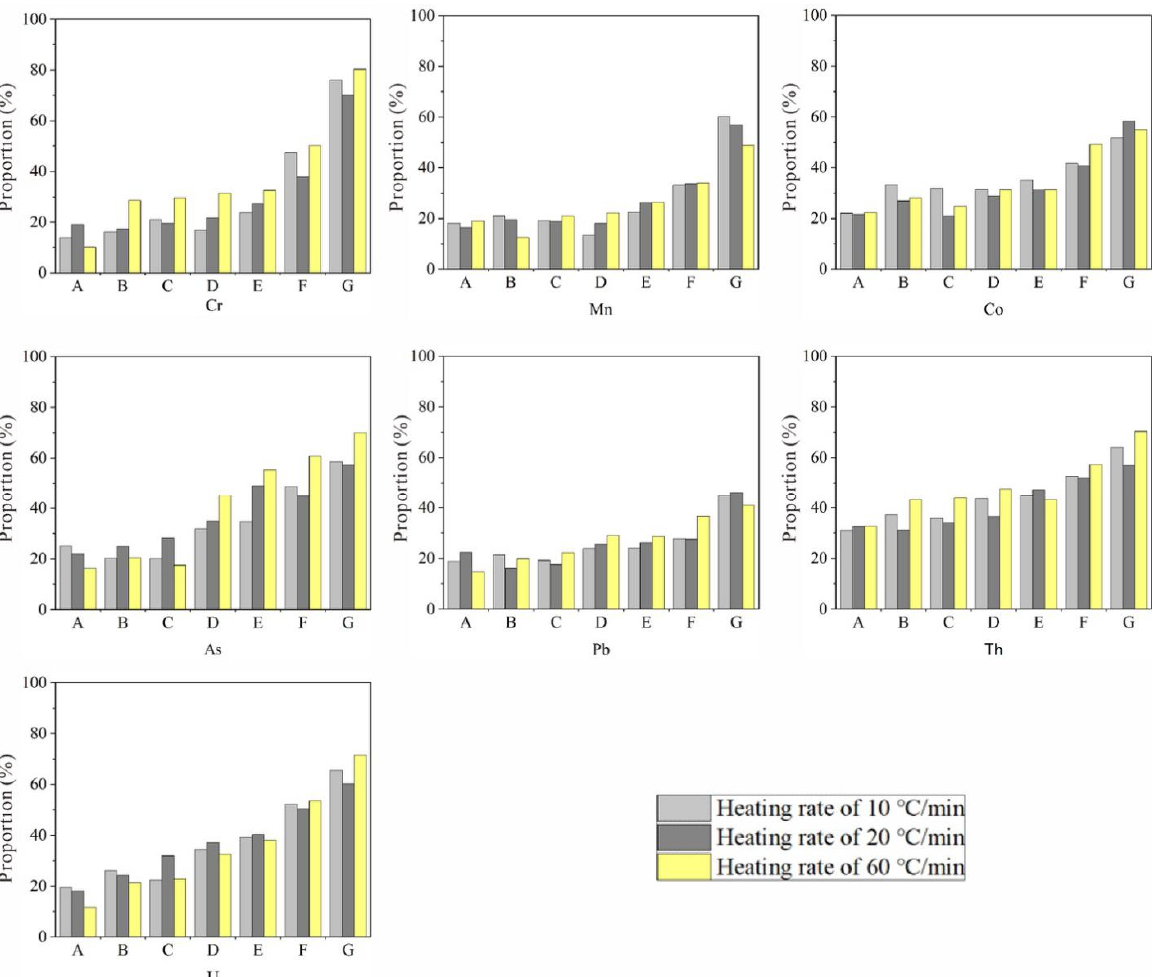
Figure 4. The percentage of toxic elements retained in the combustion of of coal, municipal sludge and their blends. A: coal, B: C90MS10, C: C80MS20, D: C70MS30, E: C60MS40, F: C50MS50, G: municipal sludge.